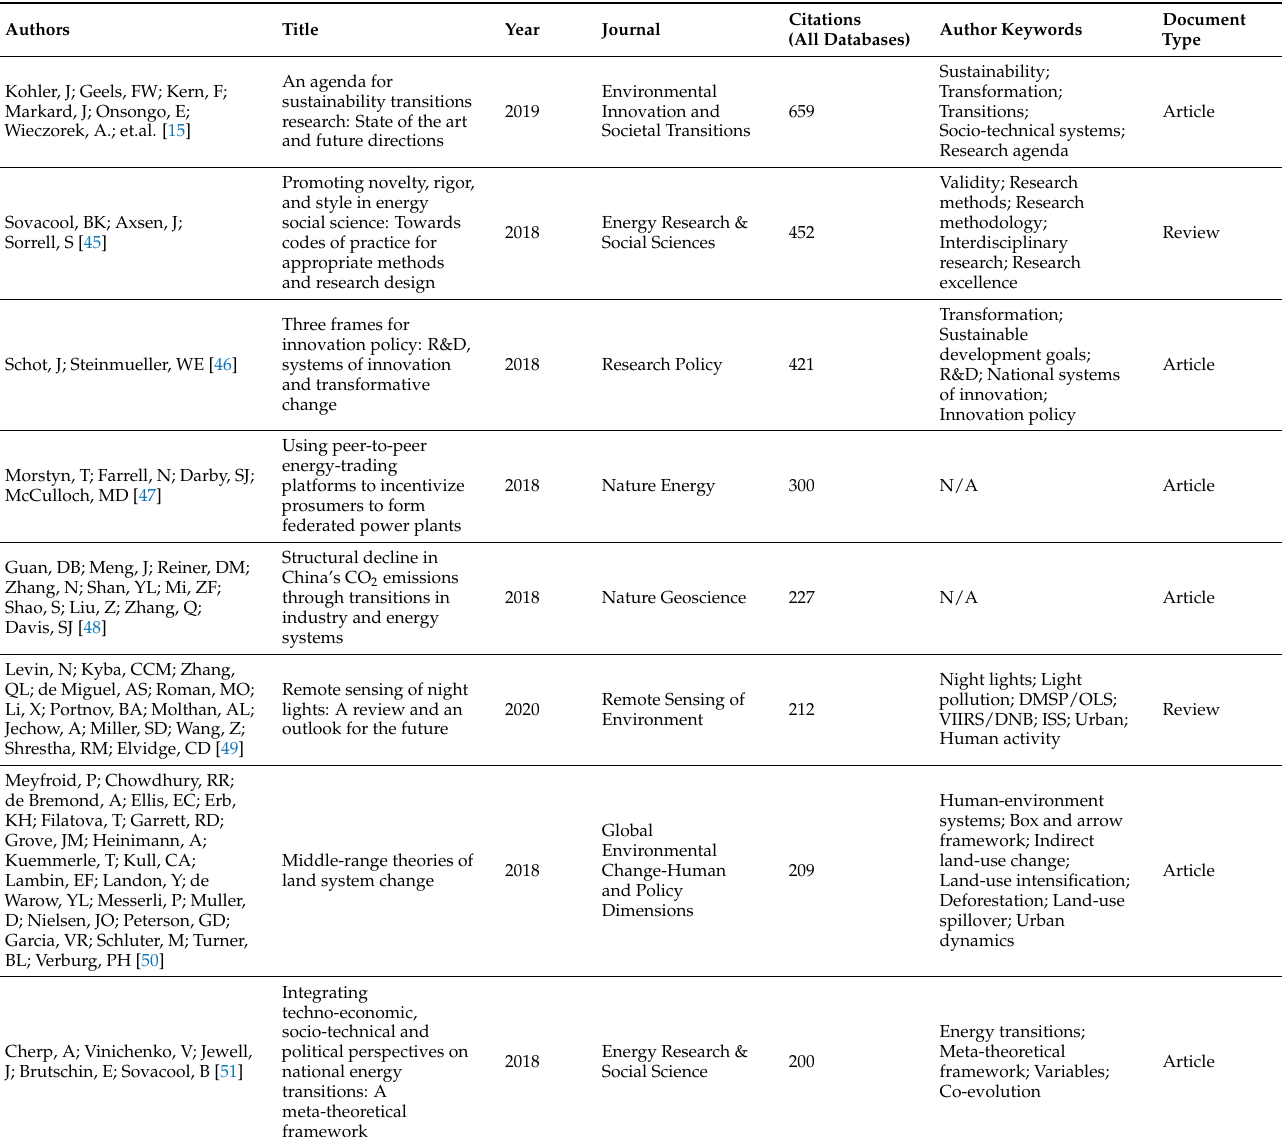
Table 1. Top 12 most cited papers for the combination social innovation–energy